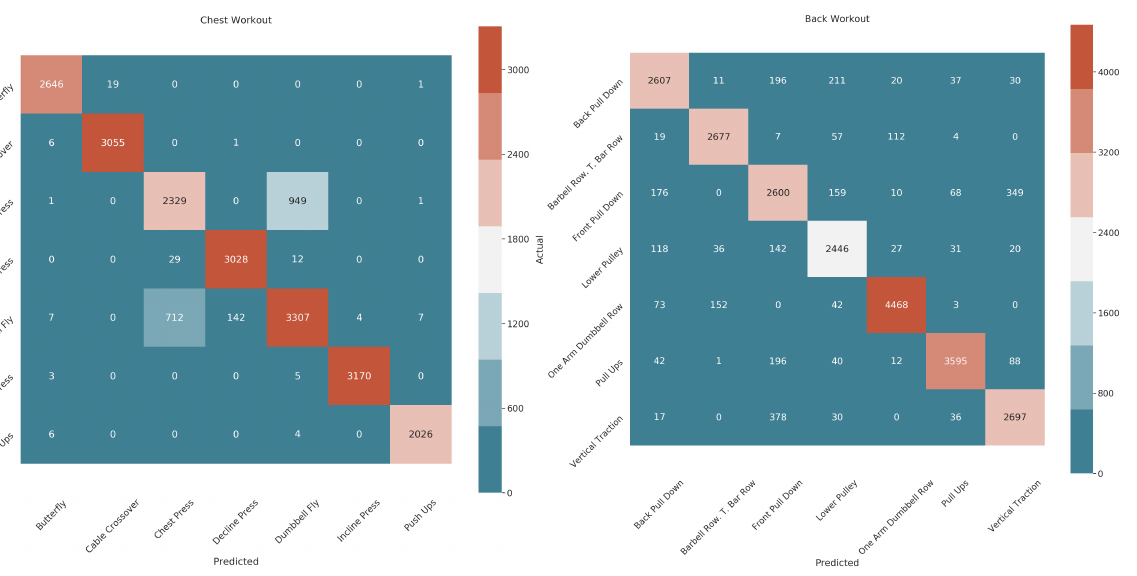
Figure 4. Confusion matrices for activity recognition of chest (on the left ) and back (on the right ) workout